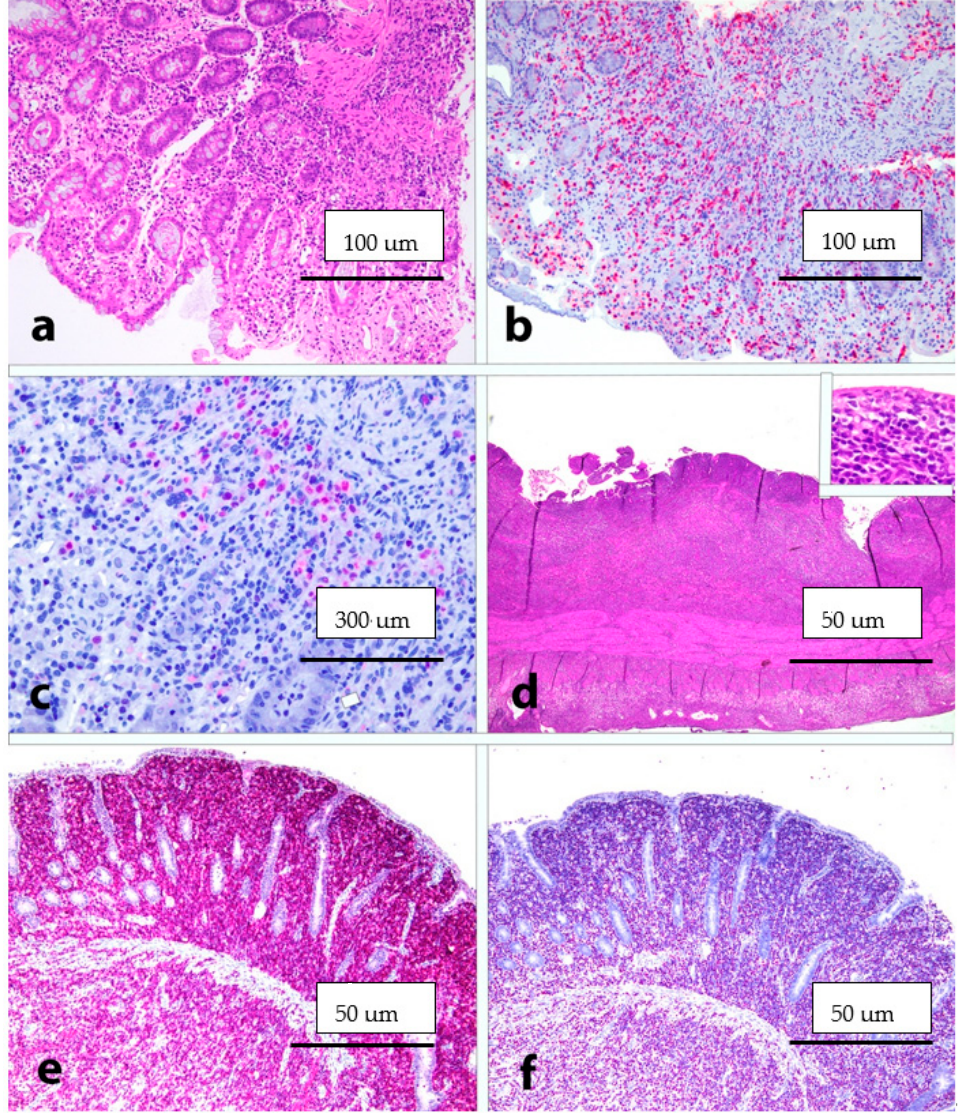
Figure 1. ( a ) PTLD: Medium power view showing a mucosal infiltrate with preserved tissue ar- chitecture (HE, 20 × magnification); ( b ) PTLD: CD3 staining highlighting the mucosal infiltrate (immunohistochemical staining, 20 × ); ( c ) PTLD: EBER positivity (in situ hybridization; 40 × magnifi- cation); ( d ) ENKTL, nasal-type: low power view showing the neoplastic infiltrate diffusely involving the intestinal wall; in the inset: details of neoplastic cells (HE, 10 × magnification; inset, 40 × magnifi- cation); ( e ) ENKTL, nasal-type: CD56 expression (immunohistochemical staining, 10 × magnification); ( f ) ENKTL, nasal-type: EBER positivity (in situ hybridization; 10 × magnification). All images are originals from Prof.